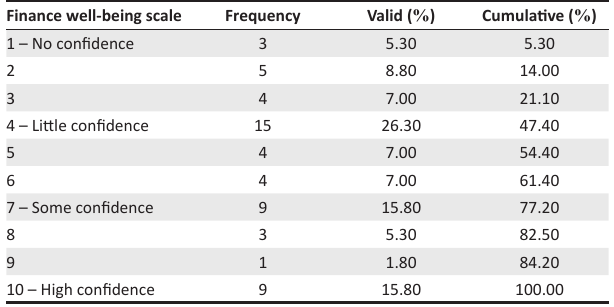
TABLE 5: How confident are you that you could find the money to pay for a financial emergency that costs approximately $1000 (or R12 000)? Finance well-being scale